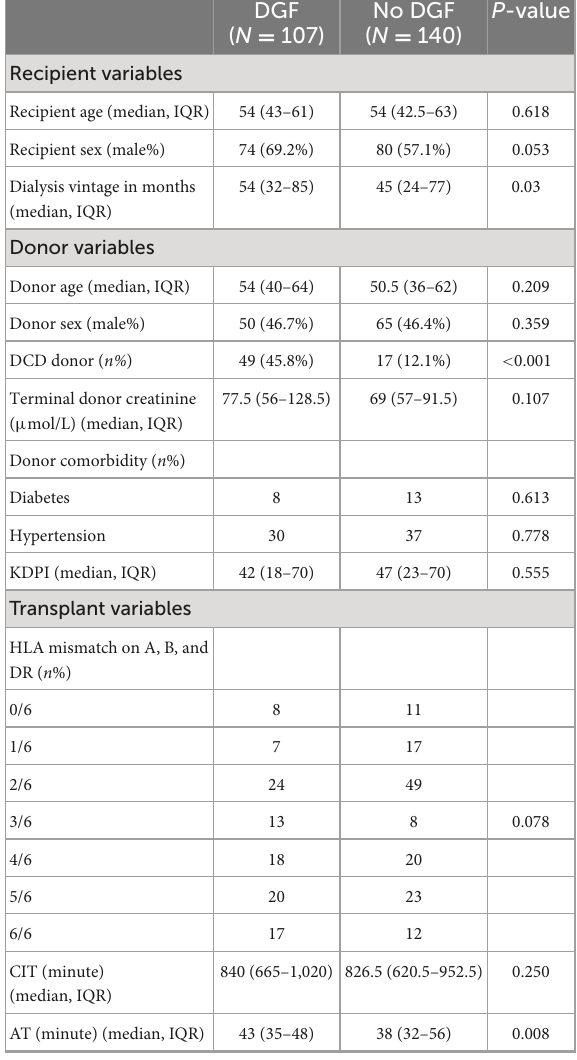
TABLE 2 Summary of the recipient, donor, and transplant variables and their impact on DGF.